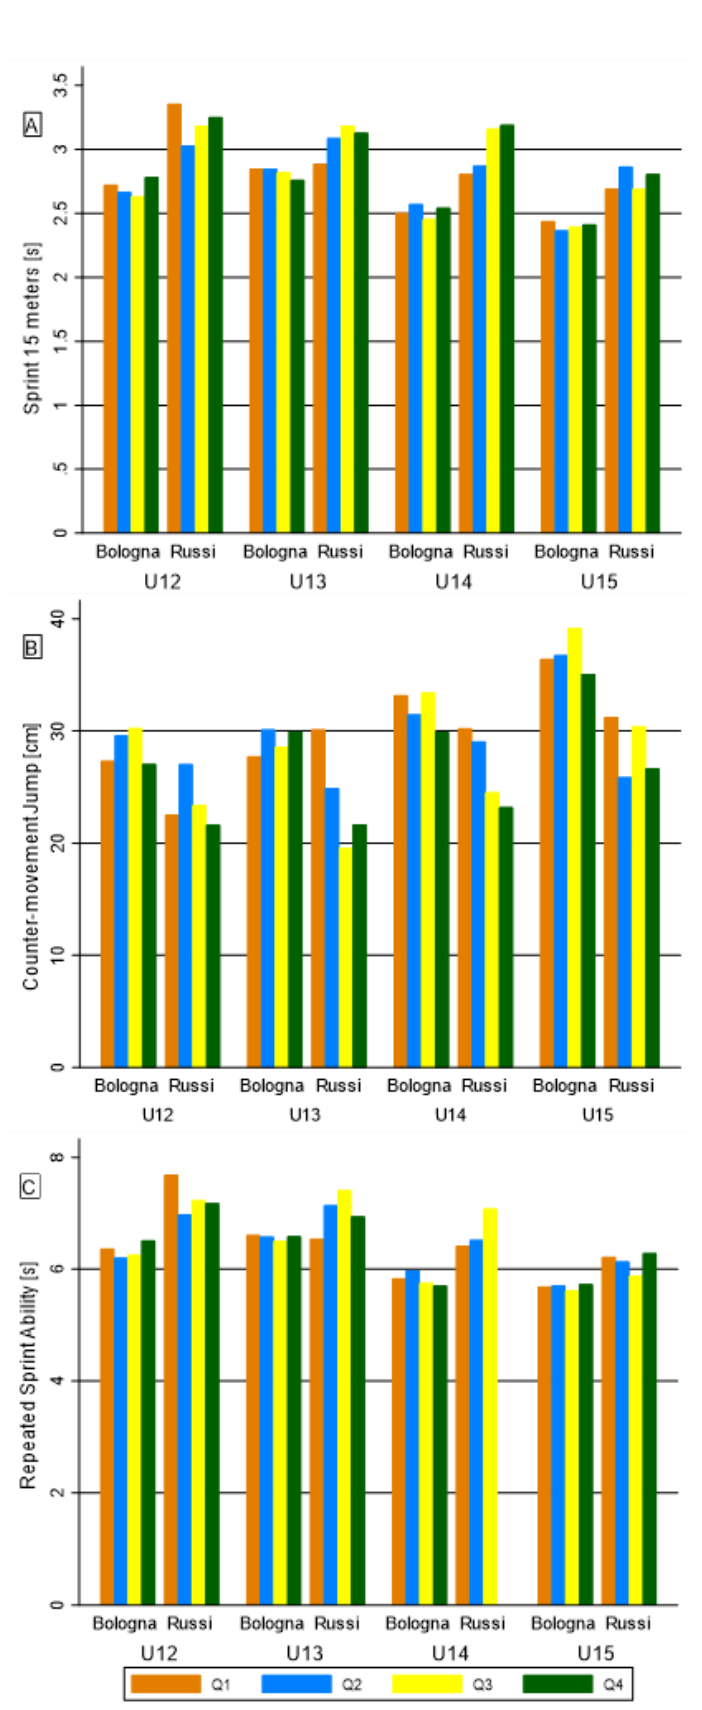
Figure 4 . Bar graph of the Relative Age Effect on performance competition level discriminants, among teams and categories: ( A ) 15-m sprint; ( B ) CMJ; ( C ) RSA.